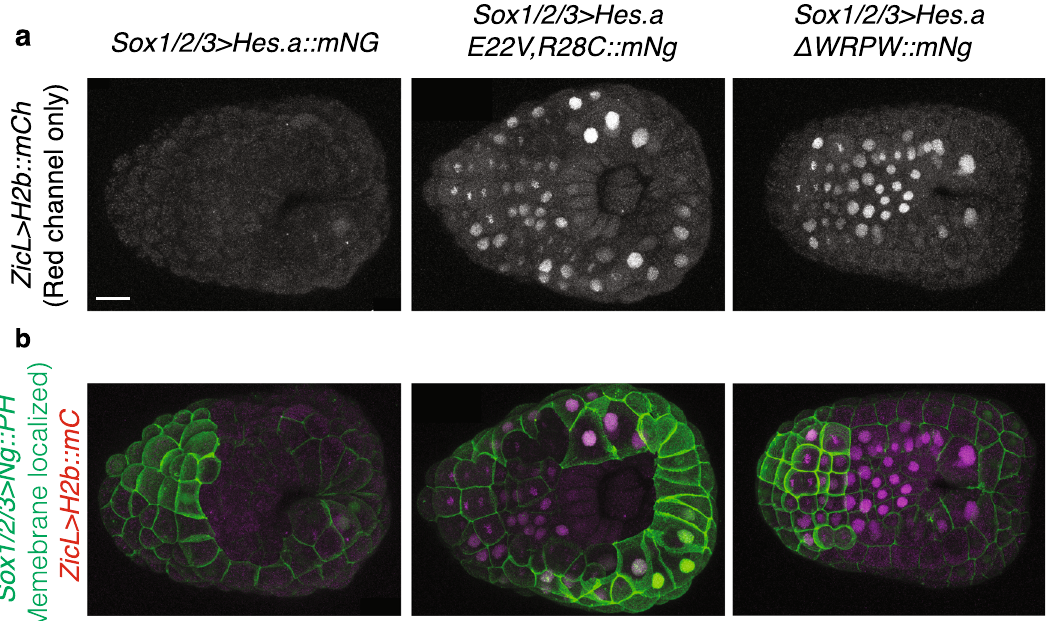
Fig. 3 Hes.a represses ZicL . a Red fl uorescence in in gastrula stage Ciona embryos that have been from a ZicL > H2b::mC reporter plasmid. The embryos have been coelectroporated with Hes.a fusion proteins that were expressed earlier in development using plasmids containing the Sox1/2/3 regulatory region. b Merged green and red fl uorescent channel from the image in a . Because most of the Hes.a proteins have been degraded by this stage, cells that were previously expressing Hes.a transgenes were determined by the presence of the membrane localized mNG::PH fusion protein expressed using the Sox1/2/3 regulatory region. Scale bar = 20 μ m. All images are representative of >3 biological